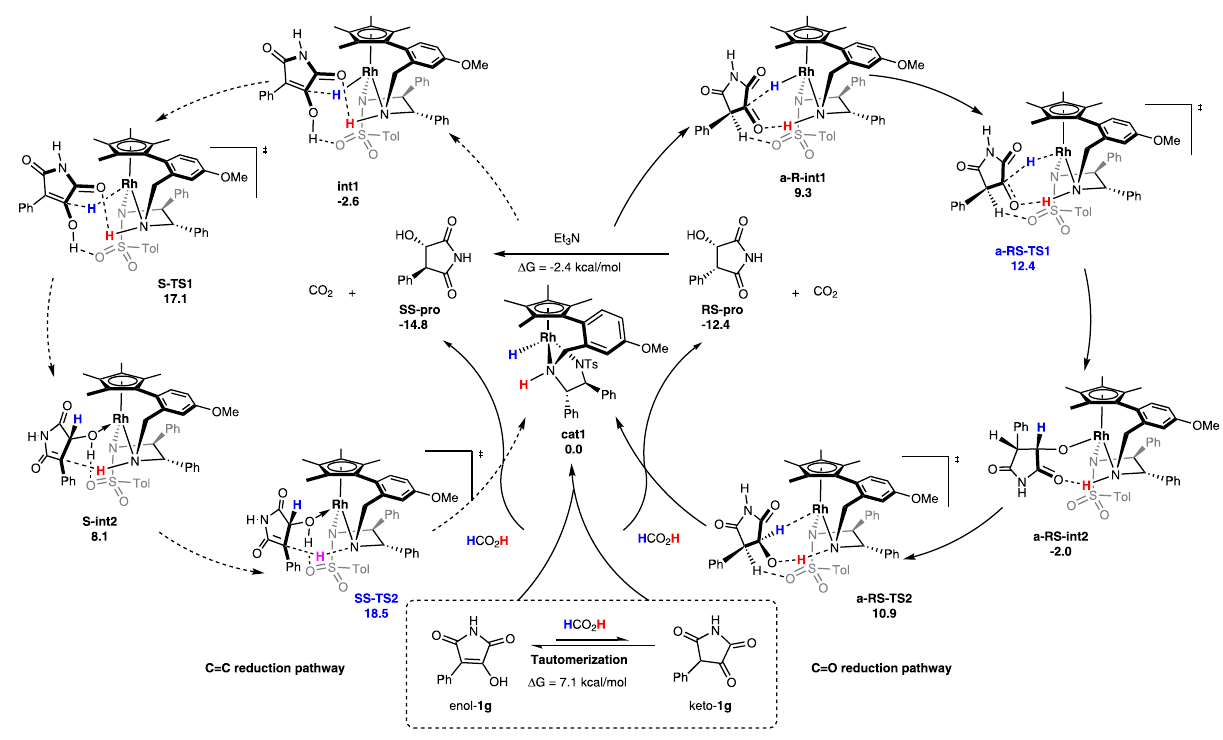
compounds, intermediates and transition states are provided below the corre- sponding chemical structures and the energies are given in